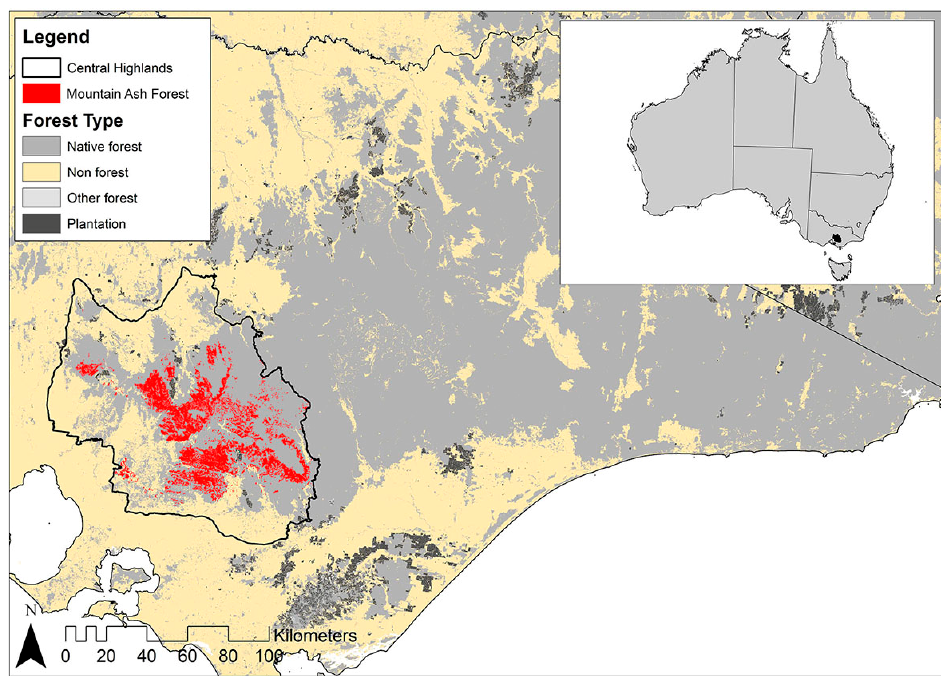
Figure 1. The location of the Central Highlands of Victoria, southeastern Australia.